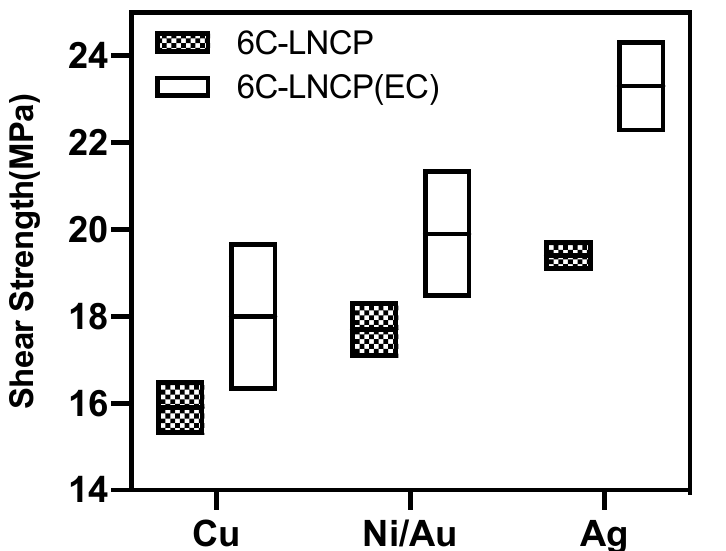
Figure 7. Shear strength of LNCP-6C joints with Cu, Ni/Au and Ag substrates, respectively (EC: ethyl cellulose).